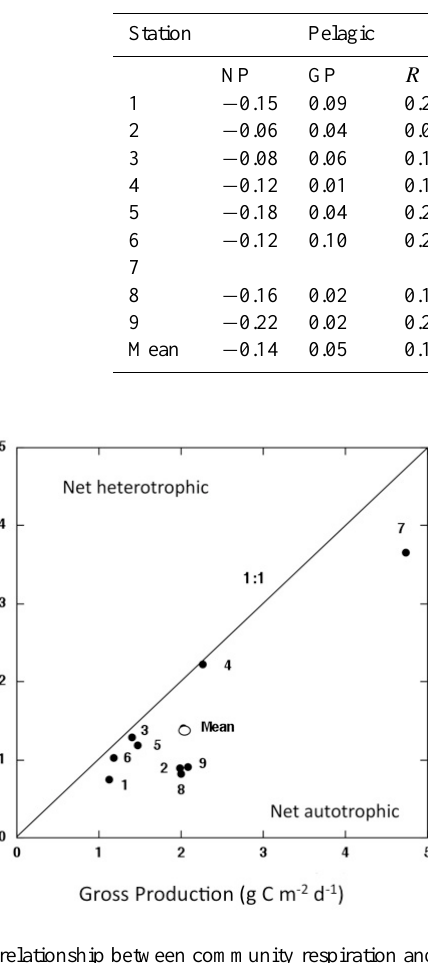
Fig. 3. The relationship between community respiration and gross production in the nine lagoon communities. The open symbol shows the mean